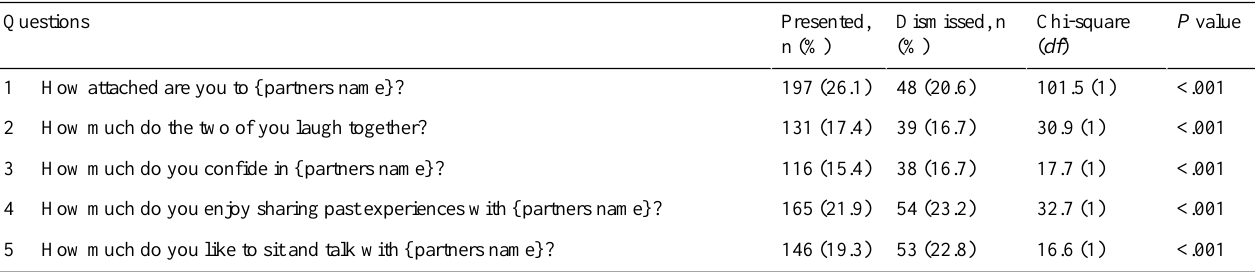
Table 2. Ecological momentary assessment questions presented and dismissed.